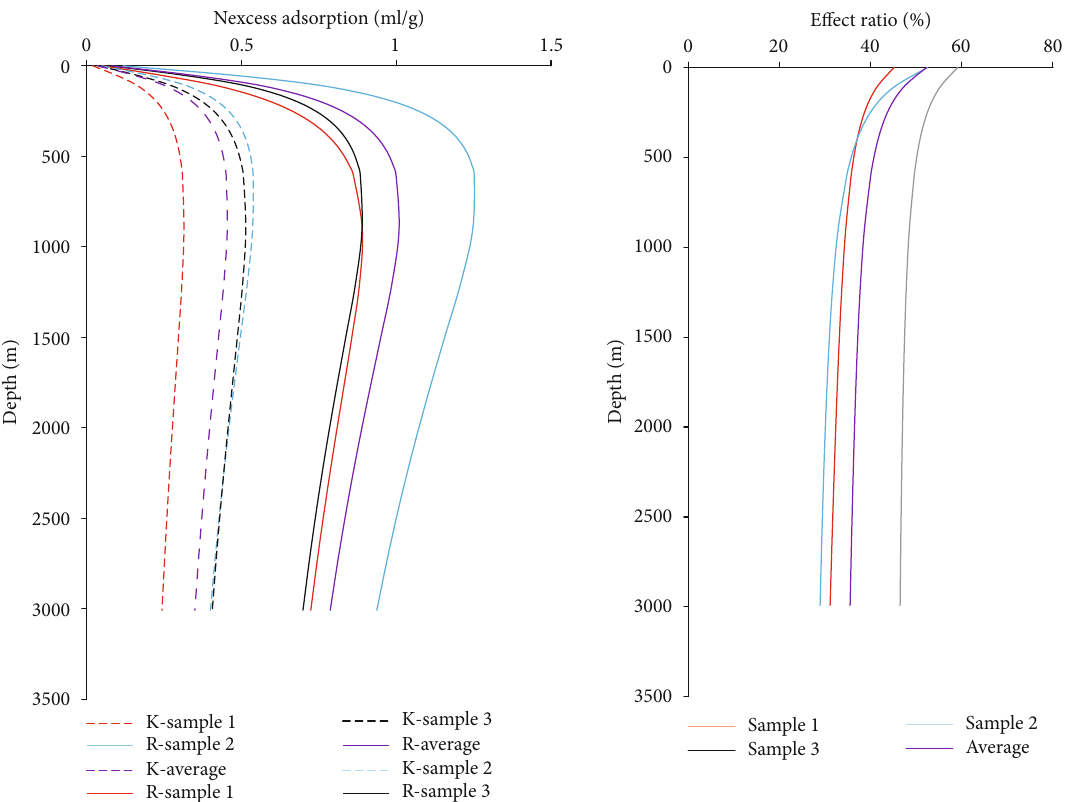
Figure 9: The adsorption amount of organic matte and its contribution to the total adsorption amount changing with depth in